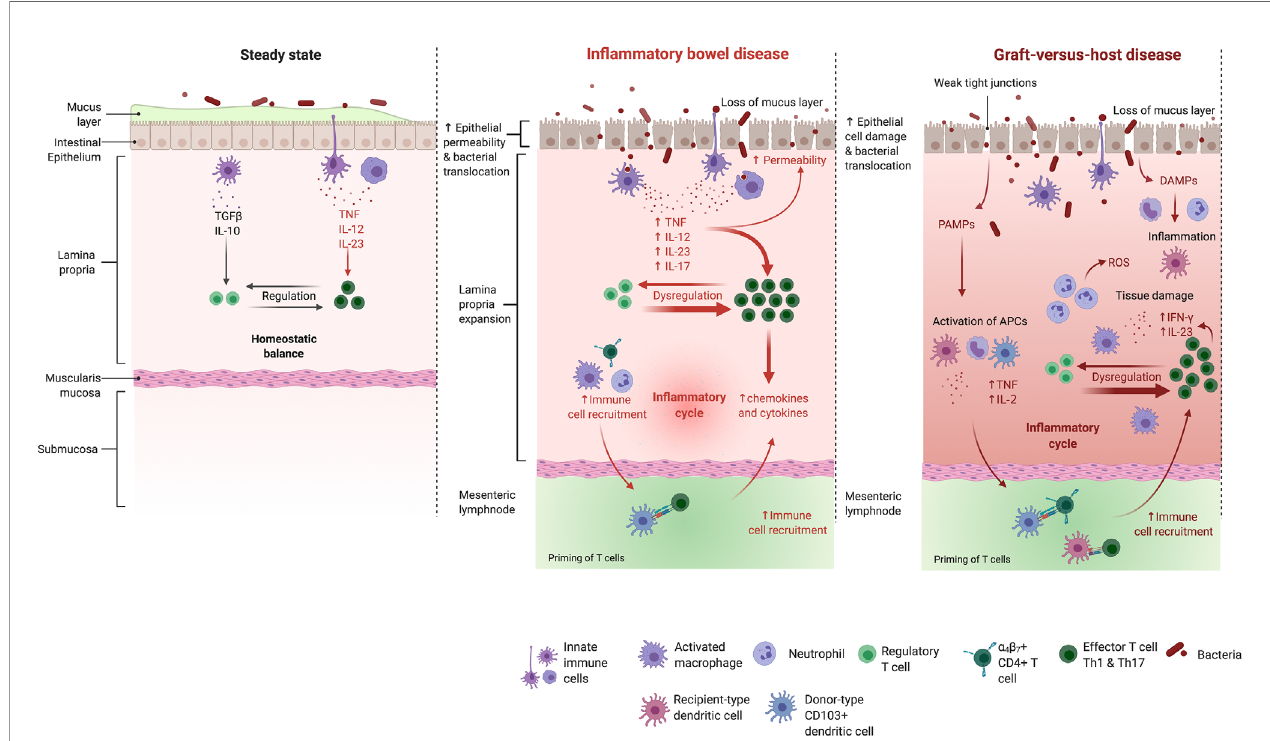
FIGURE 1 | The intestinal mucosa in the healthy bowel, in IBD and GVHD. Mechanisms maintaining the healthy intestinal barrier (e.g. a thick mucus layer and tight junctions) are disrupted in the mucosa of IBD patients. The balance between effector- and regulatory T cells gets disturbed which leads to an activation of different effector T cell subtypes and their uncontrolled migration into the in fl amed intestine. Also in GHVD pathogenesis, the intestinal barrier gets disrupted. Intestinal injury due to administered conditioning regiment leads to the translocation of bacteria, PAMPs and DAMPs. Neutrophils are recruited and promote tissue damage through reactive oxygen species secretion. The costimulatory activity of host antigen presenting cells is enhanced. Donor T cells are primed, proliferate and differentiate in response to host stimulatory APCs. Th1 cytokines (IFN- g , IL-2, and TNF) and chemokines are released in large quantities. A complex cascade including cellular mediators (e.g. cytotoxic T cells and macrophages) and soluble in fl ammatory effectors (e.g. TNF and IFN- g ) collectively promotes local tissue damage and further drives the in fl ammatory cycle. IL, interleukin; TGF b , transforming growth factor b ; TNF, tumor necrosis factor; IFN, interferon; ROS, reactive oxygen species; PAMPs, pathogen associated molecular patterns; DAMPs, danger associated molecular patterns. Adapted from “ Immune response in IBD ” , by Biorender.com (2021). Retrieved from